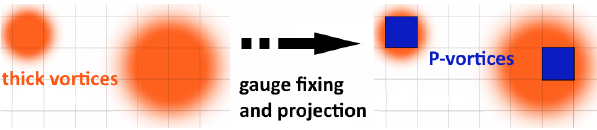
Figure 1. Vortex detection as a best fit procedure of P-vortices to thick vortices shown in a two dimensional slice through a four dimensional lattice.